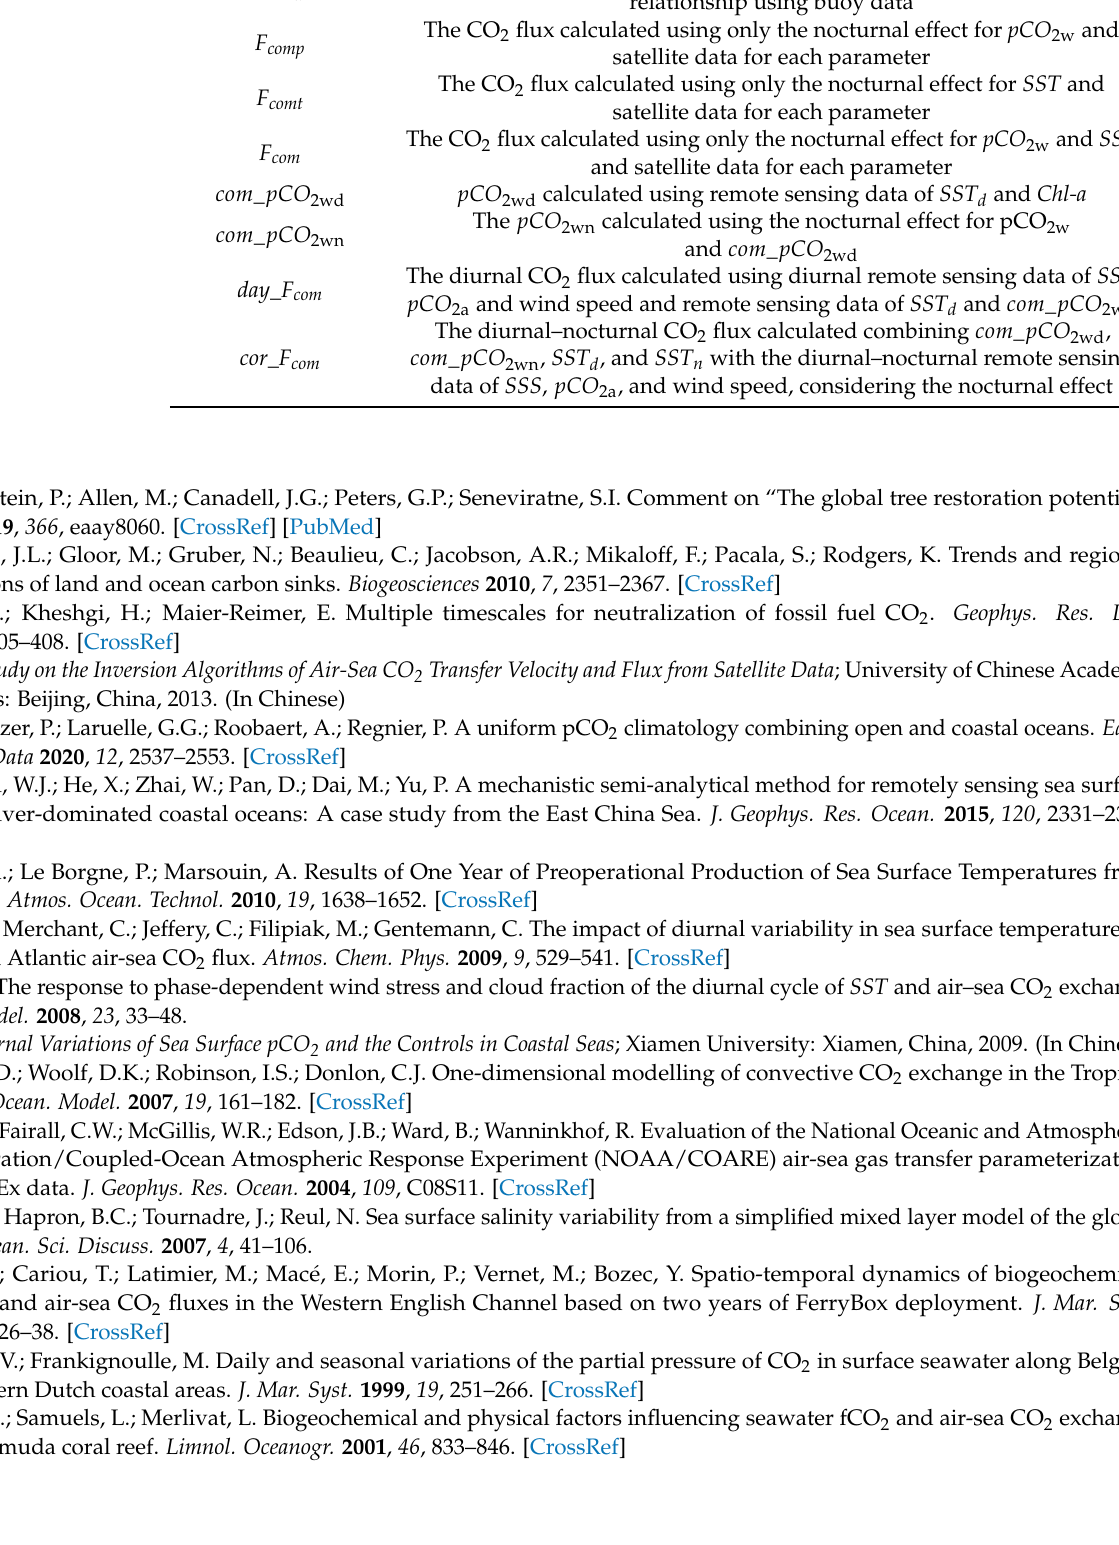
Table A1. Cont. Quantity Meaning The diurnal pCO 2w . This variable was used to establish the nocturnal pCO 2wd relationship using buoy data The nocturnal SST . This variable was used to establish the nocturnal SST n relationship using buoy data The diurnal SST . This variable was used to establish the nocturnal SST d relationship using buoy data The CO 2 flux calculated using only the nocturnal effect for pCO 2w and F comp satellite data for each parameter The CO 2 flux calculated using only the nocturnal effect for SST and F comt satellite data for each parameter The CO 2 flux calculated using only the nocturnal effect for pCO 2w and SST F com and satellite data for each parameter com _ pCO 2wd pCO 2wd calculated using remote sensing data of SST d and Chl-a The pCO 2wn calculated using the nocturnal effect for pCO 2w com _ pCO 2wn and com _ pCO 2wd The diurnal CO 2 flux calculated using diurnal remote sensing data of SSS day_F com